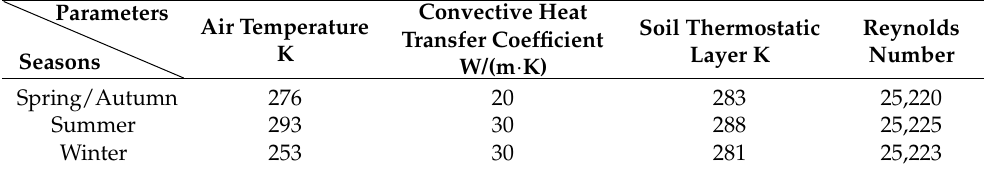
Table 5. The settings of numerical cases for different